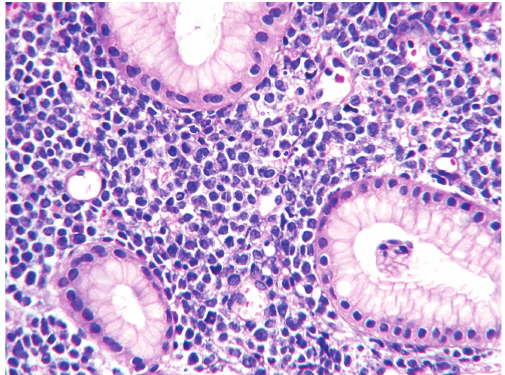
Figure 4: Trephine bone marrow biopsy, H&E, 400 × . Sheets of blasts replacing normal marrow